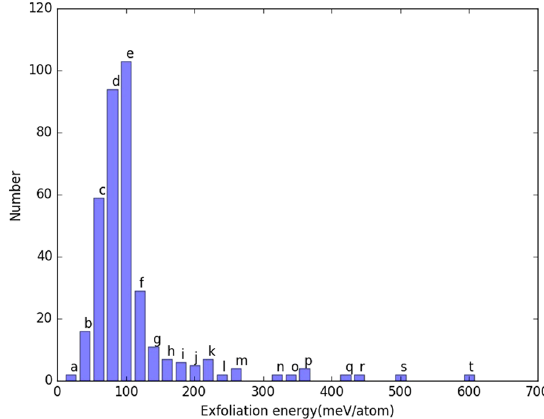
Figure 3. Exfoliation energy distribution for the materials based on the energy difference of bulk and layered materials phase. Most of the materials have E f < 200 meV/atom suggesting experimental fabrication of layered structures. Materials inside each bins are grouped and discussed below. Most of the materials are found in the 60–100 meV range. Details of structures in each bins are given in Table